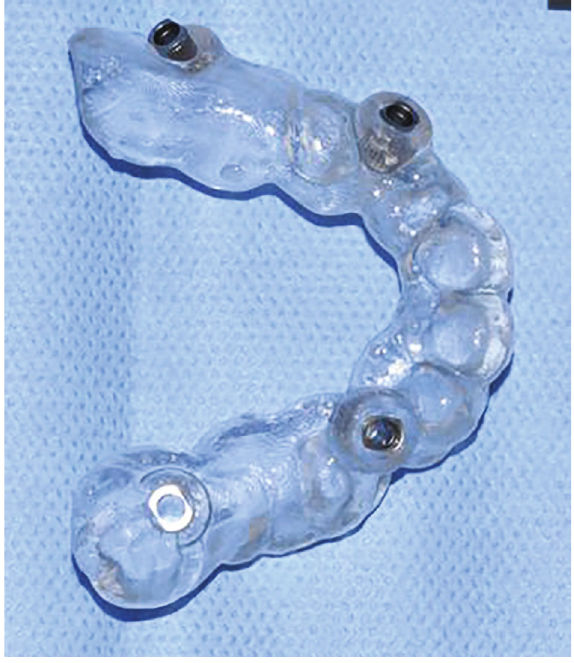
Figure 4: Surgical